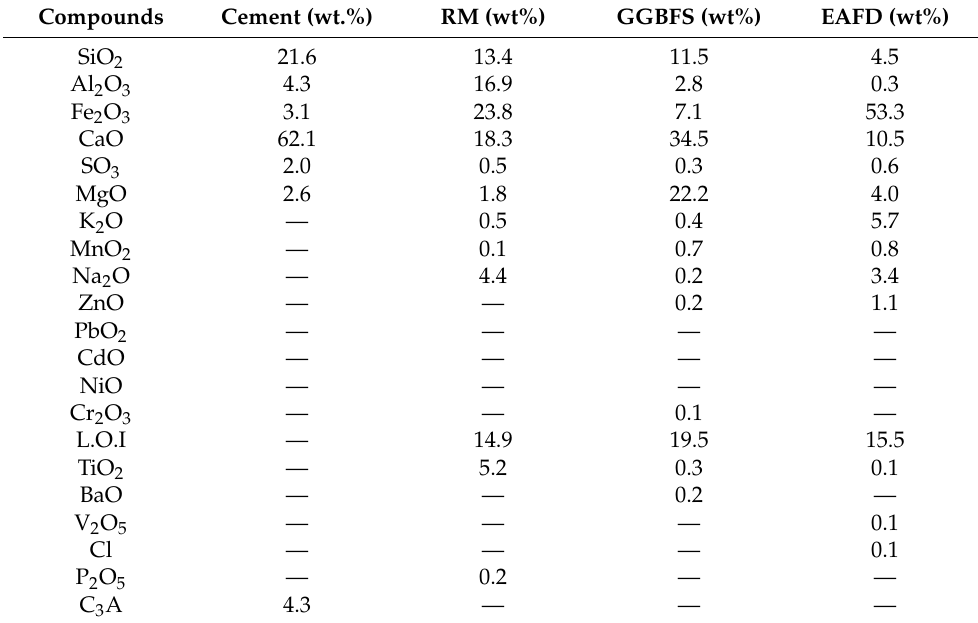
Table 1. Chemical composition of cementitious materials (assessed through XRF analysis). Compounds Cement